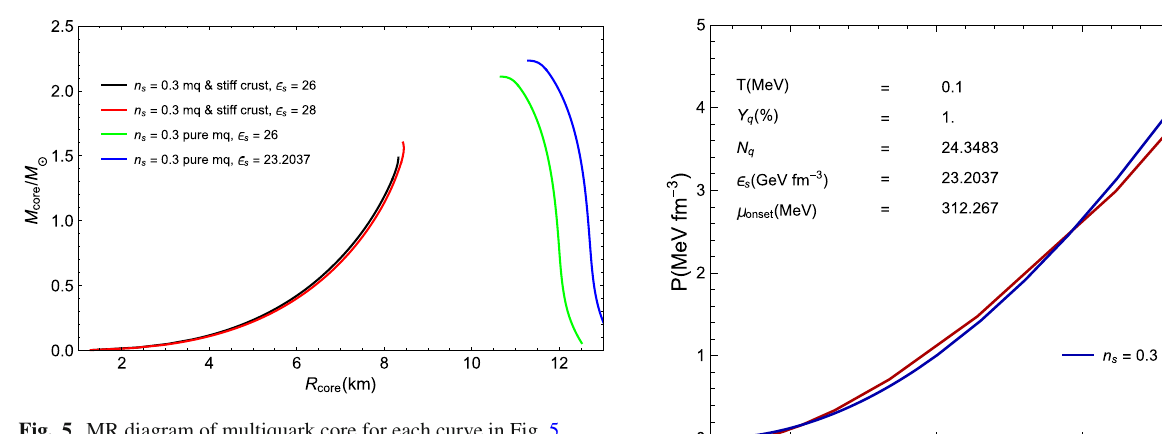
Fig. 5 MR diagram of multiquark core for each curve in Fig. 5